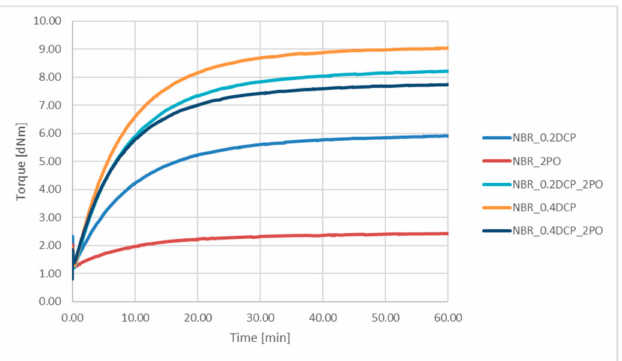
Figure 3. Crosslinking kinetics of the compounds based on acrylonitrile-butadiene rubber